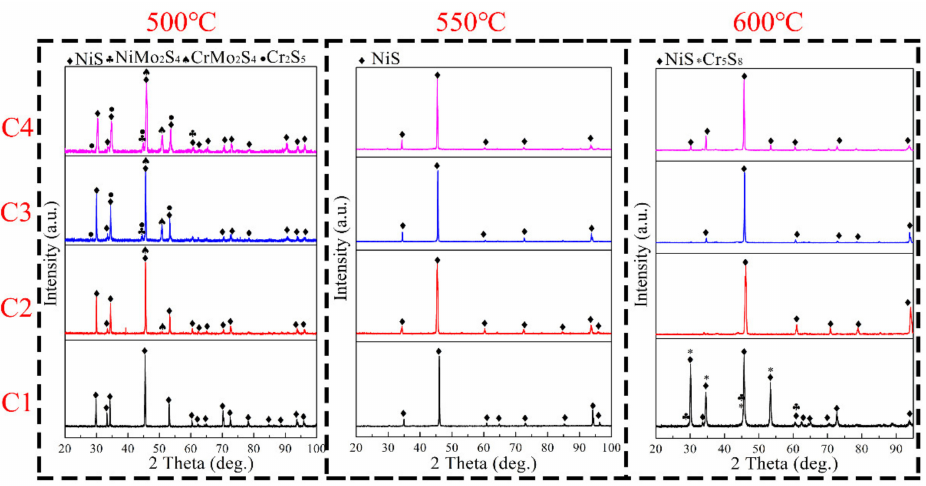
Figure 5. XRD patterns of corrosion products formed after high-temperature sulfur corrosion tests at 500–600 ◦